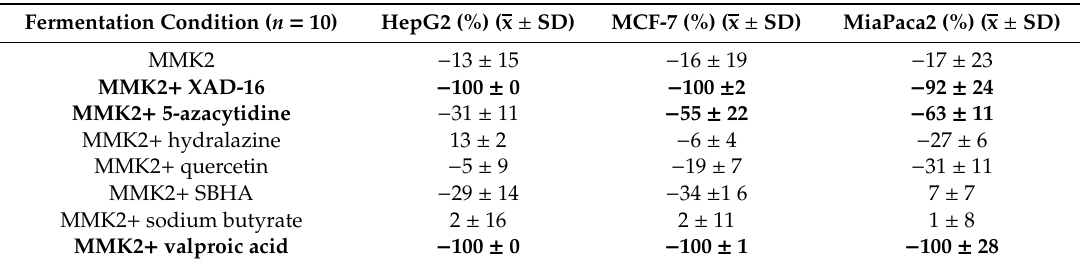
Table 1. Cytotoxic activity of di ff erent fermentation conditions against three di ff erent cancer lines (HepG2, Miapaca2 and MCF-7). Cell proliferation inhibition percentage values in negative and cell overgrowth percentage values in